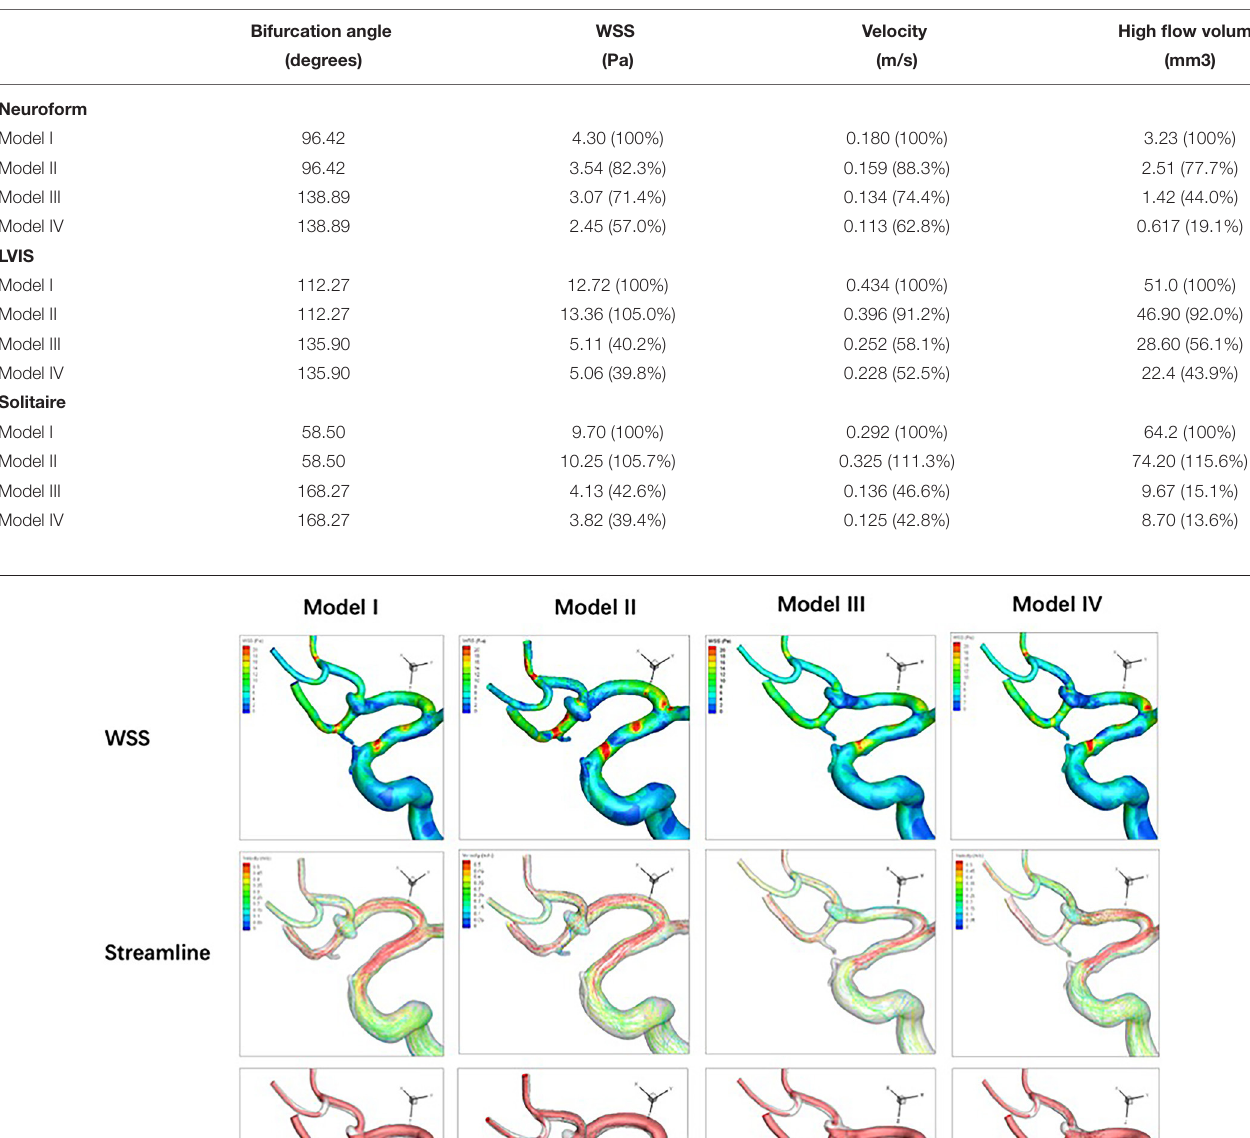
168.27 ◦ , which almost became a side-wall aneurysm ( Table 2